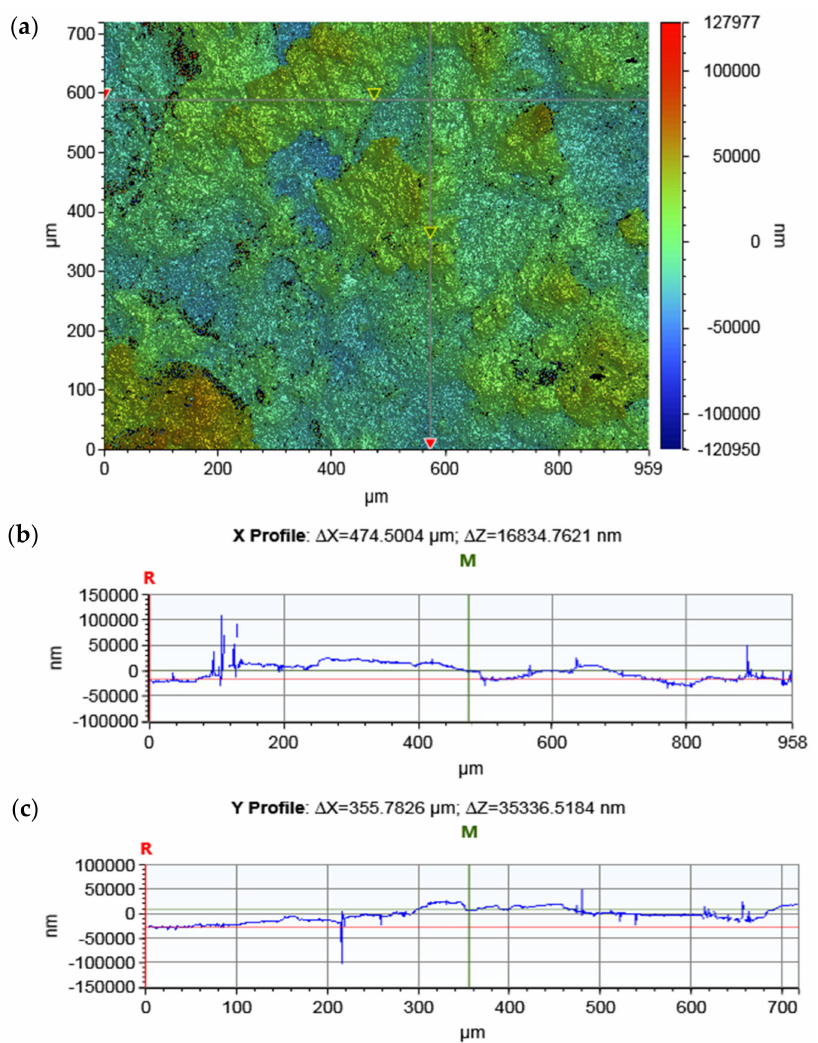
Figure 1. The surface topography and profile of the running-in coatings of specimen 2: ( a ) the surface topography; ( b ) X profile; ( c ) Y